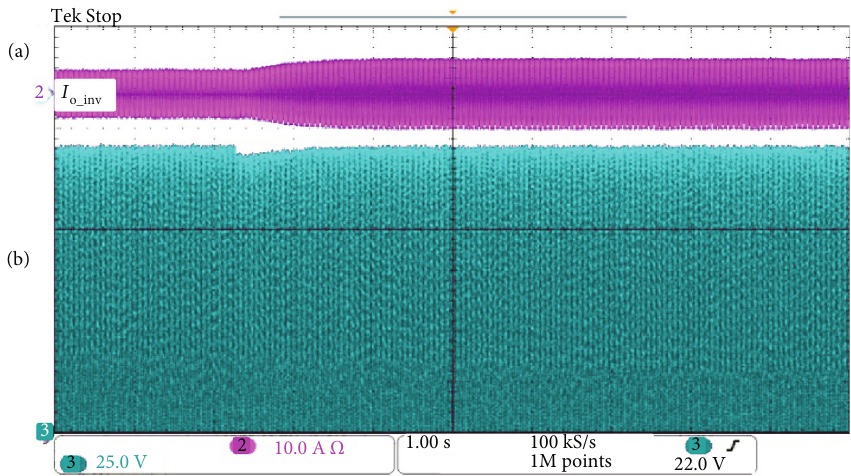
Figure 11: Power variation, for negative deviation: (a) current in residence 11 ( I Time